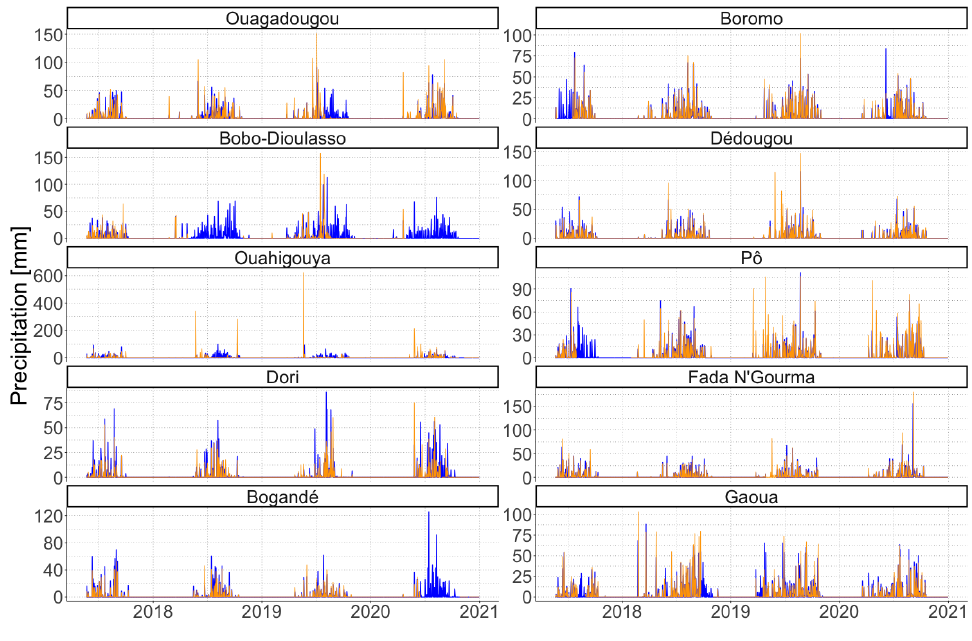
Figure 10. Comparison of precipitation time series between TAHMO stations in orange and the corre- sponding stations from meteorological service of Burkina Faso in blue. Due to large number of MVs, rainy seasons are not recorded entirely for Bobo-Dioulasso (2018 and 2020), Bogandé (2020), or only partly for Boromo (2017), Bobo-Dioulasso (2019), Ouahigouya (2018), Pô (2017), and Gaoua